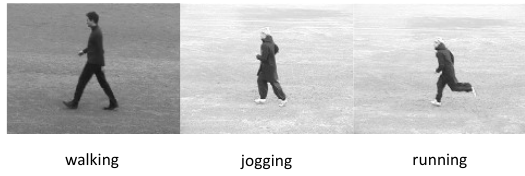
Figure 16. Samples from KTH dataset [230].